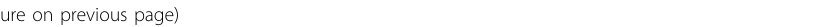
Fig. 4 Prrx1 activates TGF- β /smad pathway by transactivating TGF- β 1. A GSEA was conducted to compare high Prrx1 and low Prrx1 expression groups in fi ve published gene expression pro fi les of glioma specimens (GSE4290, GSE4412, GSE7696, GSE8692, and GSE13041). The fi ve-way Venn diagram of enrichment results in each dataset is shown and gene sets common to all datasets are extracted. B Representative enrichment plots of TGF- β /smad pathway are shown. C Western blots analysis of the TGF- β /smad pathway in the indicated cells. D The concentration of TGF- β 1 was detected in the culture medium of Prrx1 overexpressed LN229 cells and Prrx1 silencing U87MG cells by ELISA assay (mean ± SD, n = 3). E Left panel represents transcriptional expression of TGF- β 1 in GBM relative to normal brain tissues (GEPIA database, http://gepia.cancer-pku.cn/). Right panel represents Kaplan – Meier survival curve comparing the high and low expression of TGF- β 1 (determined by the quantile value) for the TCGA GBM patient cohort (GEPIA database). F Potential binding sites of Prrx1 in TGF- β 1 promotor were predicted by JASPAR 2020 (http://jaspar.genereg.net). G TGF- β 1 promotor- luciferase wild type or mutated reporters were co-transfected with pwslv-07-Prrx1, and then luciferase reporter assays were performed. H Control, Prrx1-knockdown and Prrx1-overexpression cells were used for ChIP assay. Ampli fi cation of Prrx1-binding sites 1 and 2 after ChIP analysis was indicated in the agarose gel. The gel fi gures were accompanied by the locations of molecular weight markers. I ChIP-qPCR analysis of Prrx1 enrichment in the